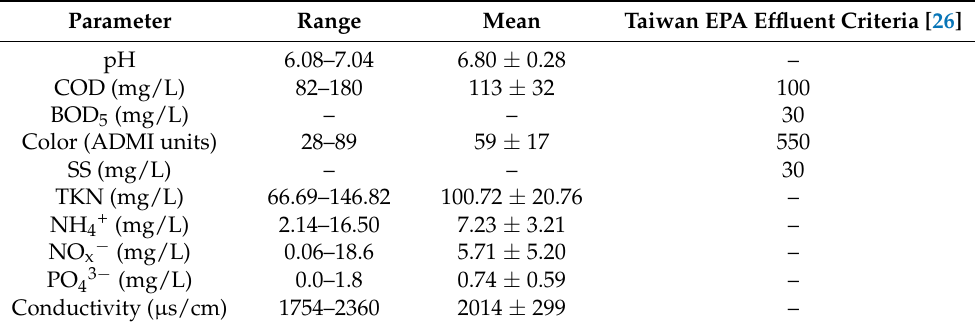
Table 1. Characteristics of the dye wastewater effluent used in this study after biological treatment and Taiwan EPA effluent criteria.